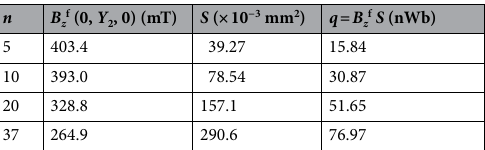
Table 3. Calculated values of magnetic flux density, total cross-sectional area, and magnetic charge under maximum bending stress.